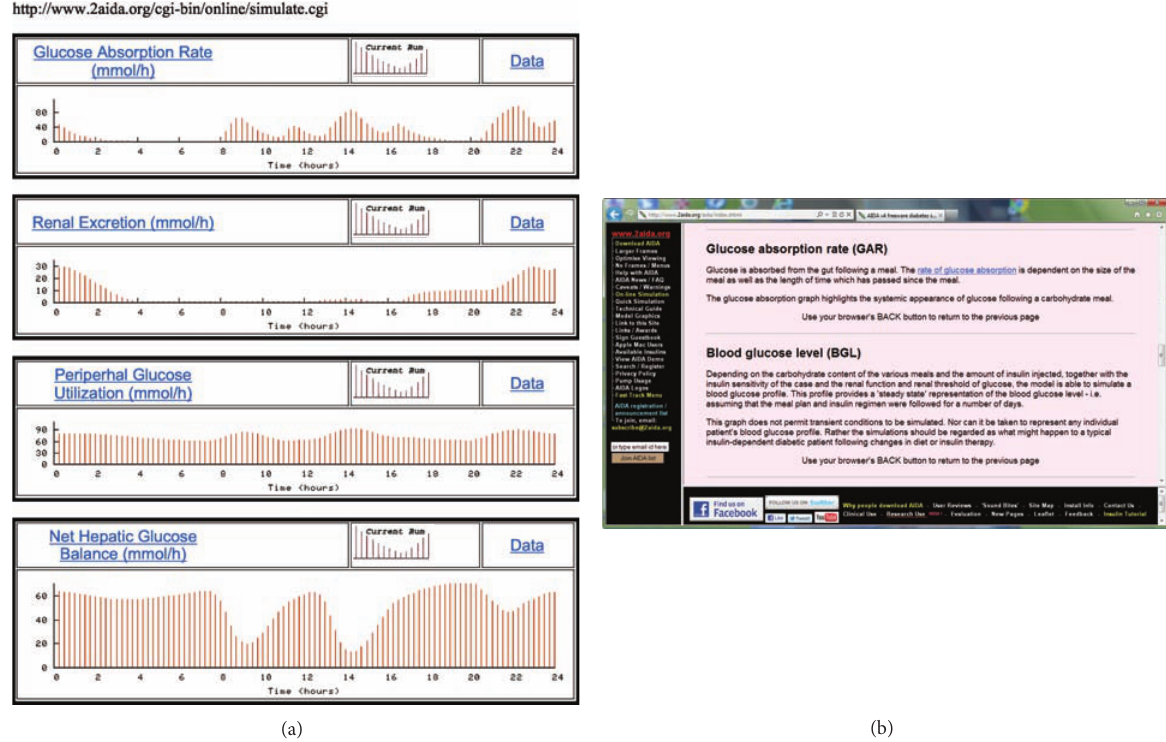
Figure 6: (a) Advanced Display option showing fluxes for the baseline simulation from Figure 4(c). “Glucose Absorption Rate” shows glucose absorption following carbohydrate ingestion in meals; “Renal Excretion” shows thepassageof glucoseinto theurine, above therenal threshold of glucose; “Peripheral Glucose Utilization” demonstrates the utilization of glucose in the periphery, while “Net Hepatic Glucose Balance” shows the production or utilization of glucose by the liver. (b) Screenshot from AIDA online 2 showing two of the entries in the online glossary—directly accessible at http://www.2aida.org/glossary—which is linked to the online simulator output. In this way, users can click on HTML links to obtain explanations about terms they do not understand or concepts with which they are unfamiliar.